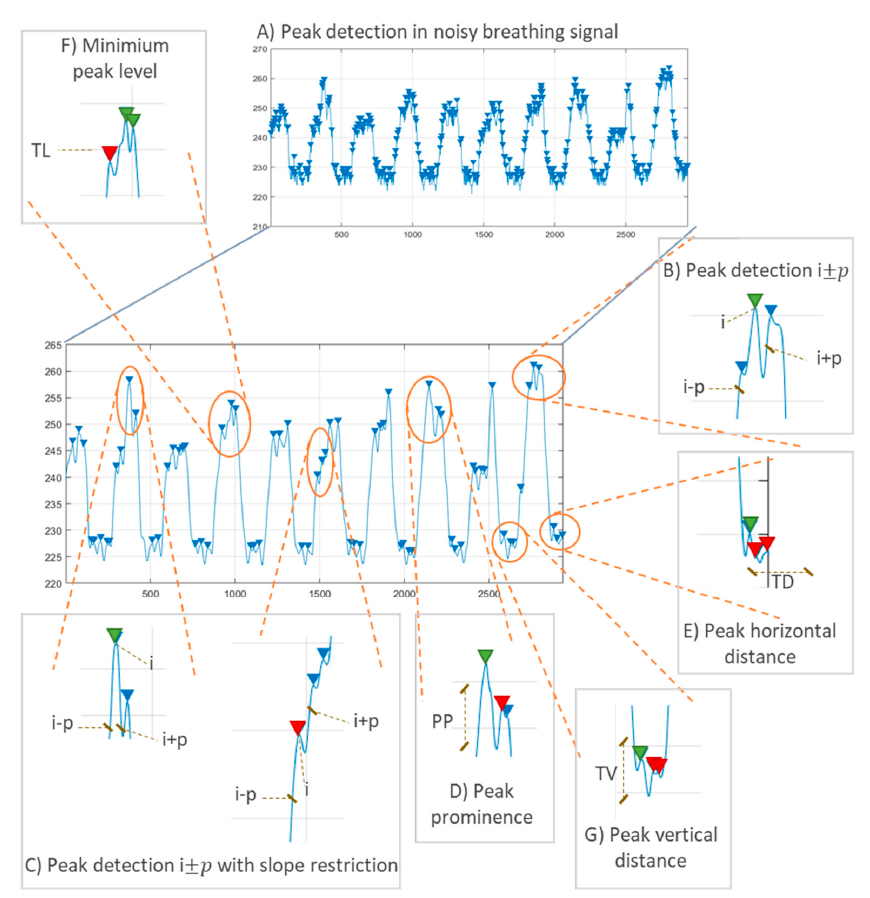
Figure 29. Peak detection of a sample respiration signal obtained from the public breathing dataset published in Reference [254]. ( A ) Peak detection of a noisy signal without filtering. ( B ) Peak detection imposing a restriction of p surrounding number of samples (in green the peak accepted). ( C ) Example of a peak accepted (left, green peak) and a peak discarded (right, red peak) when applying the slope restriction. ( D ) Example of a peak reaching (green) and not reaching (red) the minimum prominence level PP to be considered a valid peak. ( E ) Example of two peaks (red) not fulfilling the minimum horizontal distance restriction TD. ( F ) Example of a peak (red) not fulfilling the vertical minimum level restriction and two peaks that surpass level TL (green peaks). ( G ) Example of two peaks discarded (red) for not di ff ering the imposed tidal volume (TV) level from a detected peak (green). Maximum-minimum detection: A popular processing technique is to identify maximum and / or minimum points in the breathing signals ( x ). Massaroni et al. [103] used the maximum and